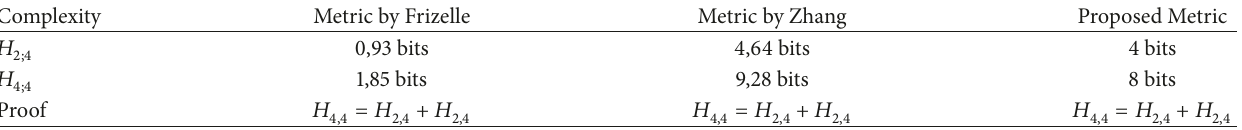
Table 10: Static complexity values and their proof.